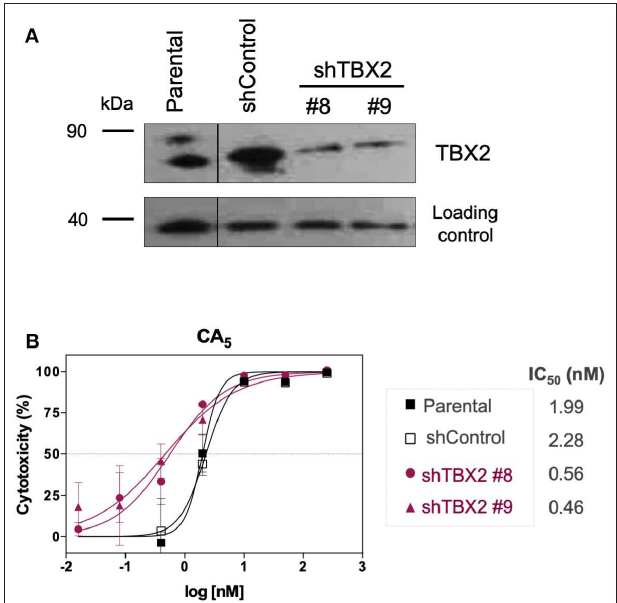
FIGURE 3 | Cytotoxicity of CA 5 on stably TBX2-knockdown cells (shTBX2). (A) TBX2 protein expression in parental, shControl and shTBX2 clones #8 and #9 501mel cell models, achieved by Western blot. (B) Cytotoxicity profiles of 501mel cell models exposed to CA 5 . IC 50 (nM) values for CA 5 in the 501mel cell models. Cytotoxicity curves and respective IC50 values we obtained by MTT assay, after cells were exposed to the respective drugs during 72h and calculated by non-linear regression on GraphPad Prism 8.0 (GraphPad Software, USA) from three independent experiments performed in